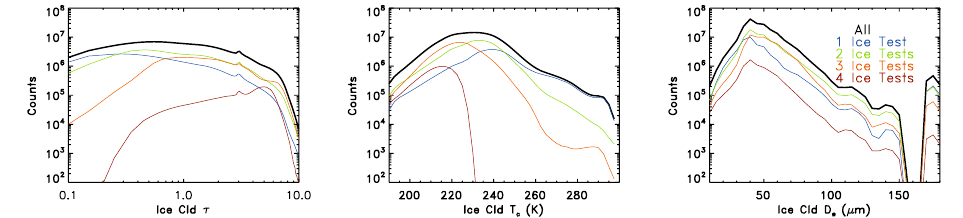
Fig. 9. Histograms of τ (left), T C , ICE (middle), and D e (right) for 2007. The FOV-scale retrievals that passed 1–4 ice tests are shown separately, as well as histograms for all retrievals (sum of tests